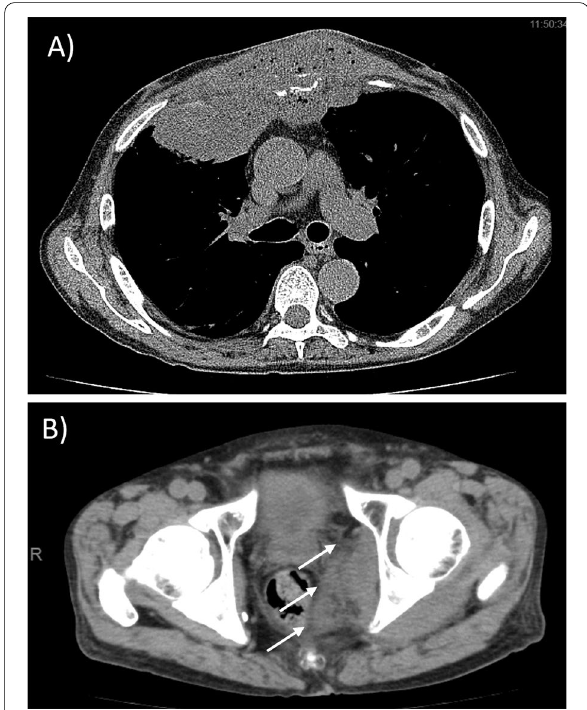
Fig. 1 Computed tomography scans revealing multiple deep organ abscesses. A whole-body computed tomography (CT) scan showing an extensive abscess from the left subcutaneous into the right anterior mediastinum ( A ) and a sciatic rectus fossa abscess ( B